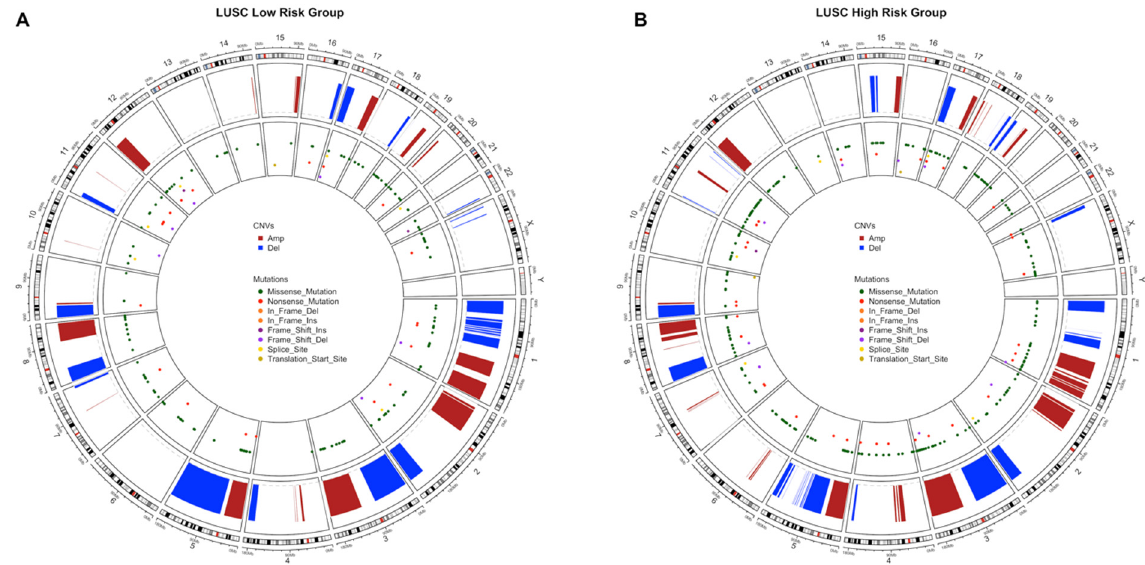
Figure 15. Circos plot of chromosome regions containing all SNVs and CNVs in LUSC risk groups. Significant CNVs ( q < 0.01) and all SNVs in original data are plotted together on chromosome regions in tumor samples of the LUSC risk groups. ( A ) Circos plot of the LUSC low-risk group. ( B ) Circos plot of the LUSC high-risk group.